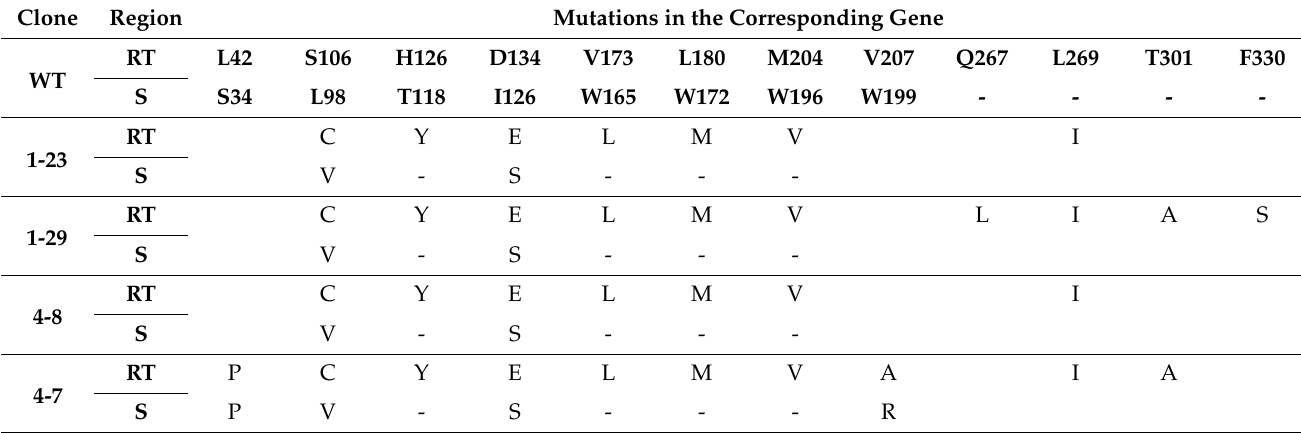
Table 2. Commonly found HBV RT mutations and corresponding surface mutations in patient-derived viral mutants. Clone Region Mutations in the Corresponding Gene